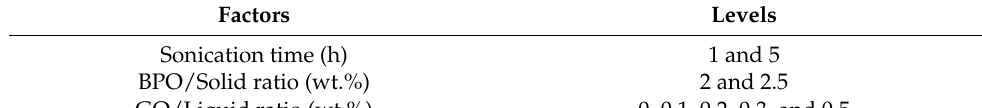
Table 1. Completely randomized experimental design with factorial structure applied in this